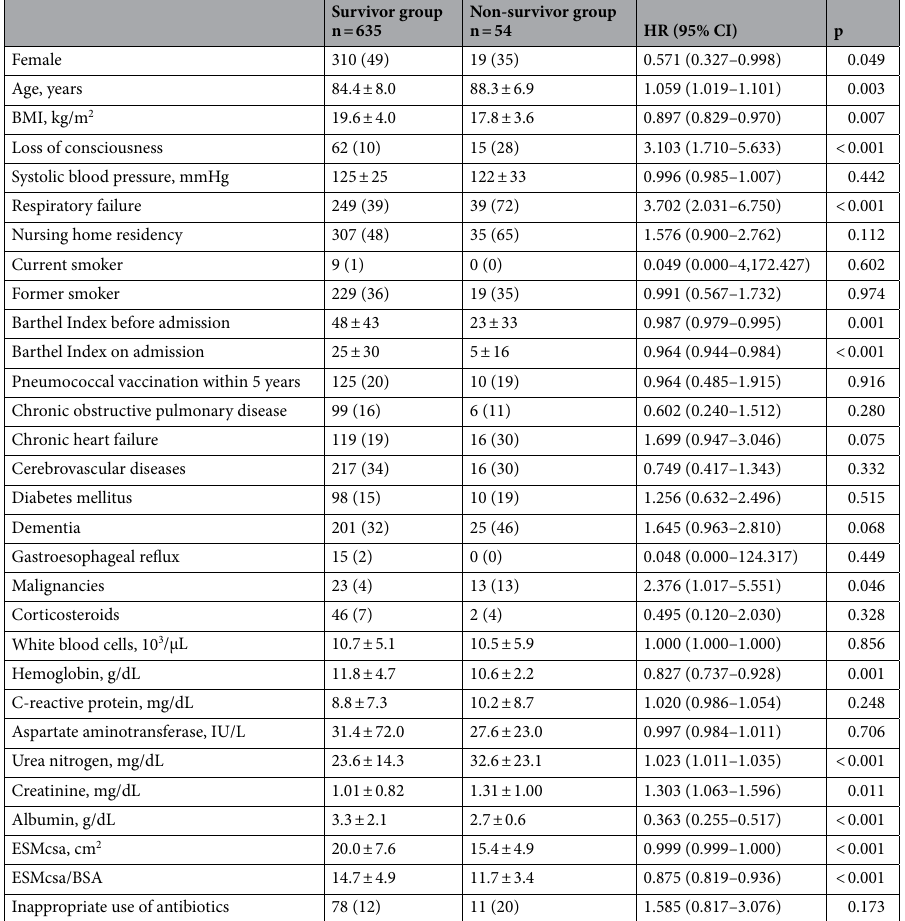
Table 4. Univariate Cox proportional hazards analyses of all-cause 30-day mortality. Data are presented as the number (%) or mean ± SD. BMI body mass index, BSA body surface area, CI confidence interval, ESM erector spinae muscle, ESMcsa cross-sectional area of ESM, HR hazard ratio, SD standard deviation.